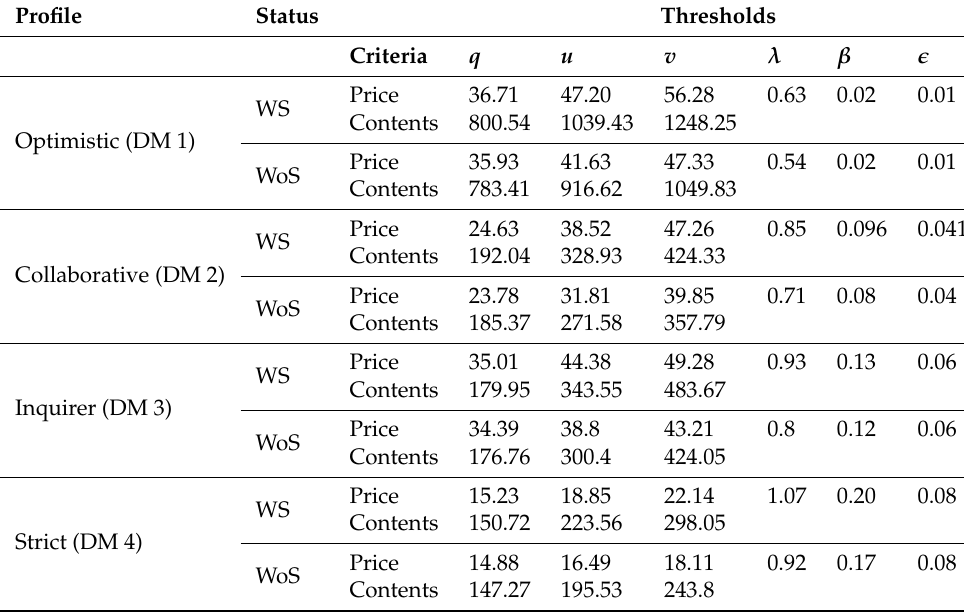
Table A4. Preference thresholds resulting from the application of the preference questionnaire in the four DM under study